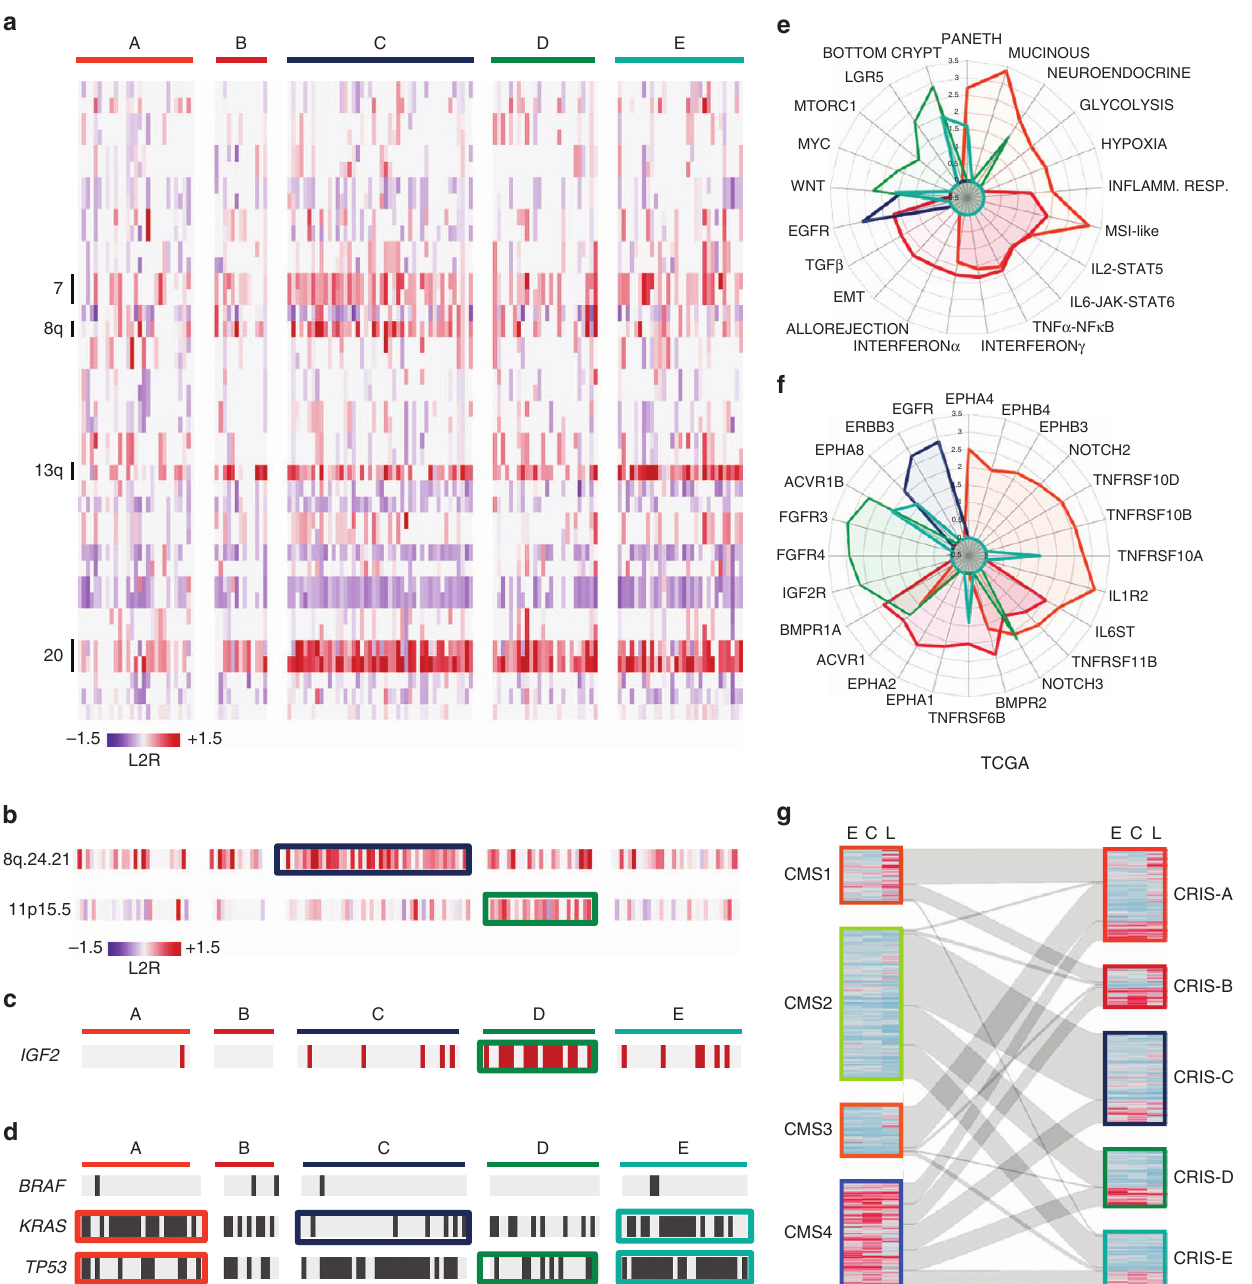
Figure 4 | Genetic and functional features of CRIS classes in MSS colorectal cancer. ( a ) Heatmap showing the distribution of broad copy number changes displaying the top-five highest average variations in individual CRIS subtypes in MSS samples of the TCGA data set. ( b ) Heatmap showing selected focal amplifications in MSS samples of the TCGA data set. Significant subtype enrichments are marked by coloured boxes. ( c ) Distribution of cases overexpressing IGF2 according to the TCGA data set 15 . ( d ) Distribution of sequence alterations in BRAF , KRAS and TP53 in MSS samples extracted from the TCGA data set. Significant subtype enrichments are marked by coloured boxes. For enrichment analysis, P o 0.05 by Fisher’s exact test was considered significant. ( e ) Radar plot showing phenotypic and functional characteristics of CRIS subtypes, expressed as normalized enrichment scores (NESs) calculated by GSEA. ( f ) Radar plot showing autocrine stimulation loops in CRIS subtypes, expressed as NESs and calculated based on gene expression analysis of ligand-receptor pairs. ( g ) Caleydo view of correspondences between CMS subtypes and CRIS classes in the TCGA data set. Heatmaps show estimates of stromal infiltration derived from gene expression analysis of specific signatures (C, CAFs; E, endothelial cells; L,